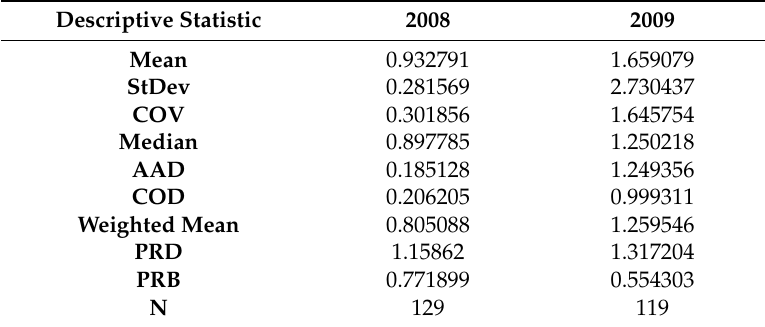
Table 1. Land ratio descriptive statistics for all qualified sales in New